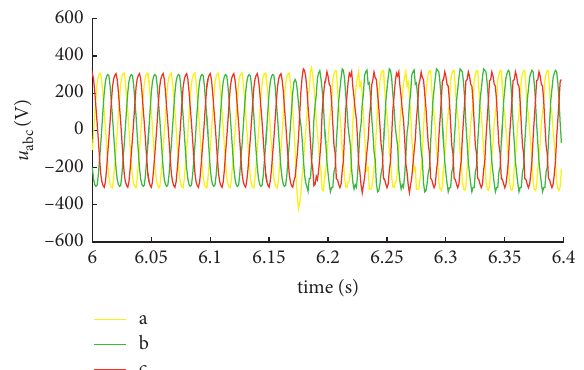
Figure 12: Voltage waveforms of the ESS (output power falls from 40kW to 10 kW).